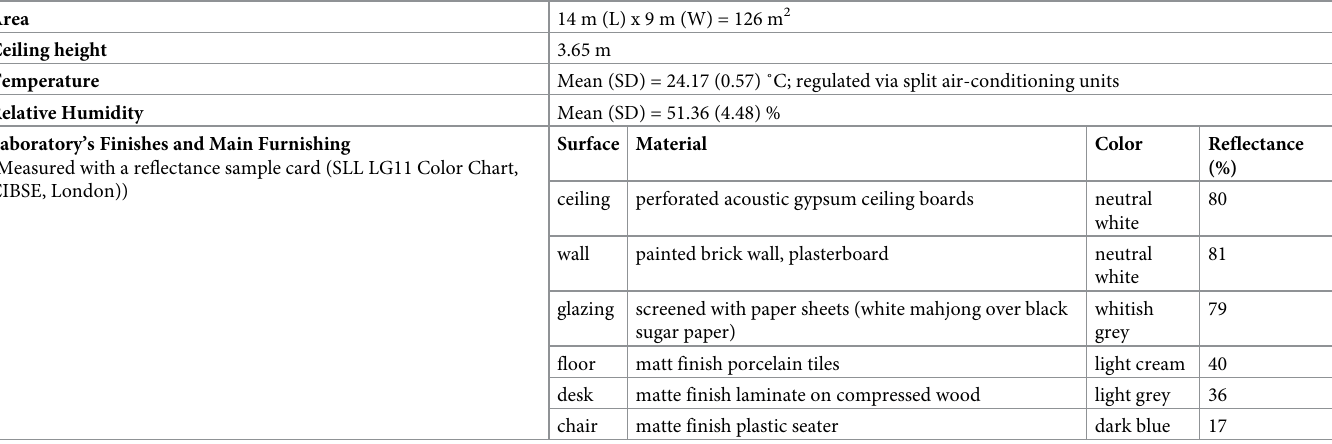
Table 1. Laboratory’s condition throughout the study